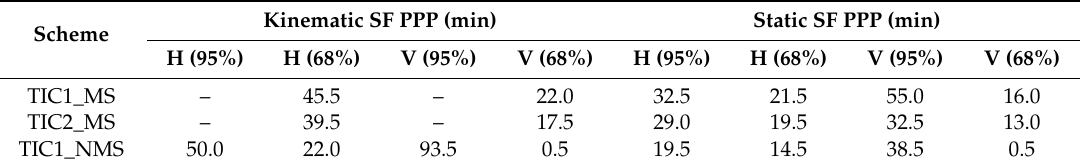
Table 8. The convergence times of GPS static and kinematic SF PPP in MS and NMS of TIC1 or TIC2.